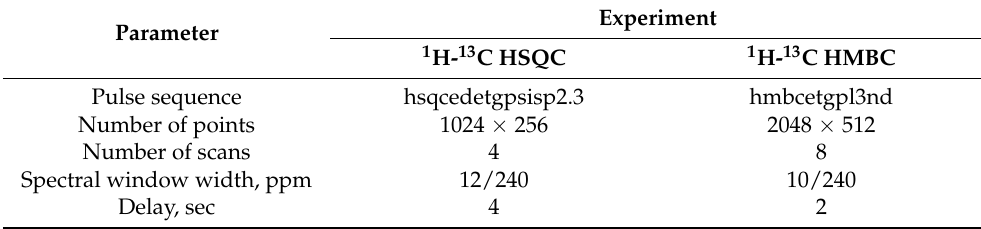
Table 1. 2D-NMR spectra registration